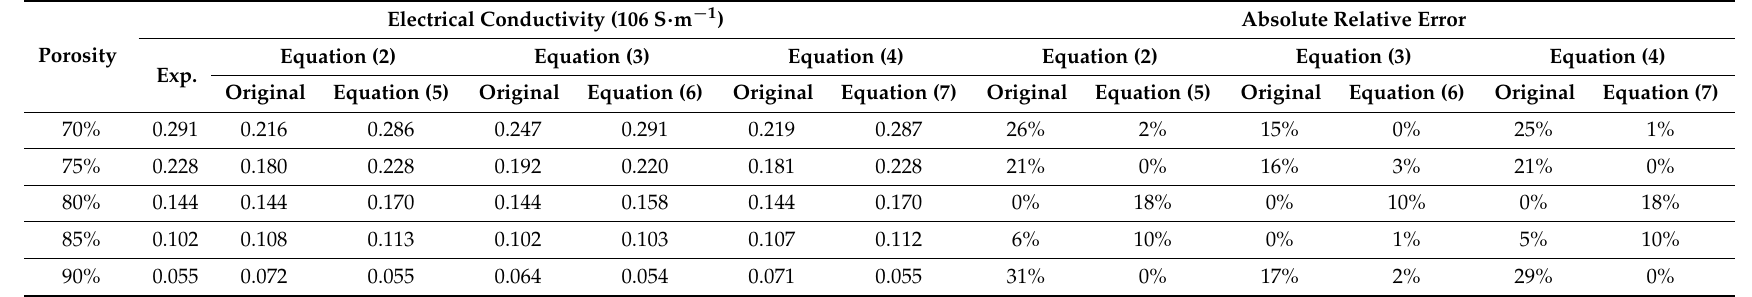
Table 1. Experimental data from Zhou et al. [40] and calculated values of electrical conductivity of sintered copper fibres using different models.